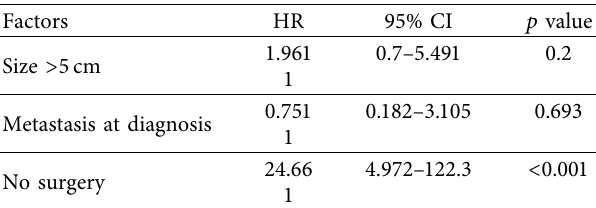
Figure 1: Kaplan–Meier survival curves in all 60 patients with MPNST. (a) OS according to tumour size ( ≤ 5 cm versus > 5cm). (b) OS according to stage (localised versus metastatic disease). (c) OS according to surgery of the primary tumour (presence versus absence of surgery). MPNST, malignant peripheral nerve sheath tumour; OS, overall survival. Table 2: Multivariate analysis of prognostic factors for OS in 60 patients with